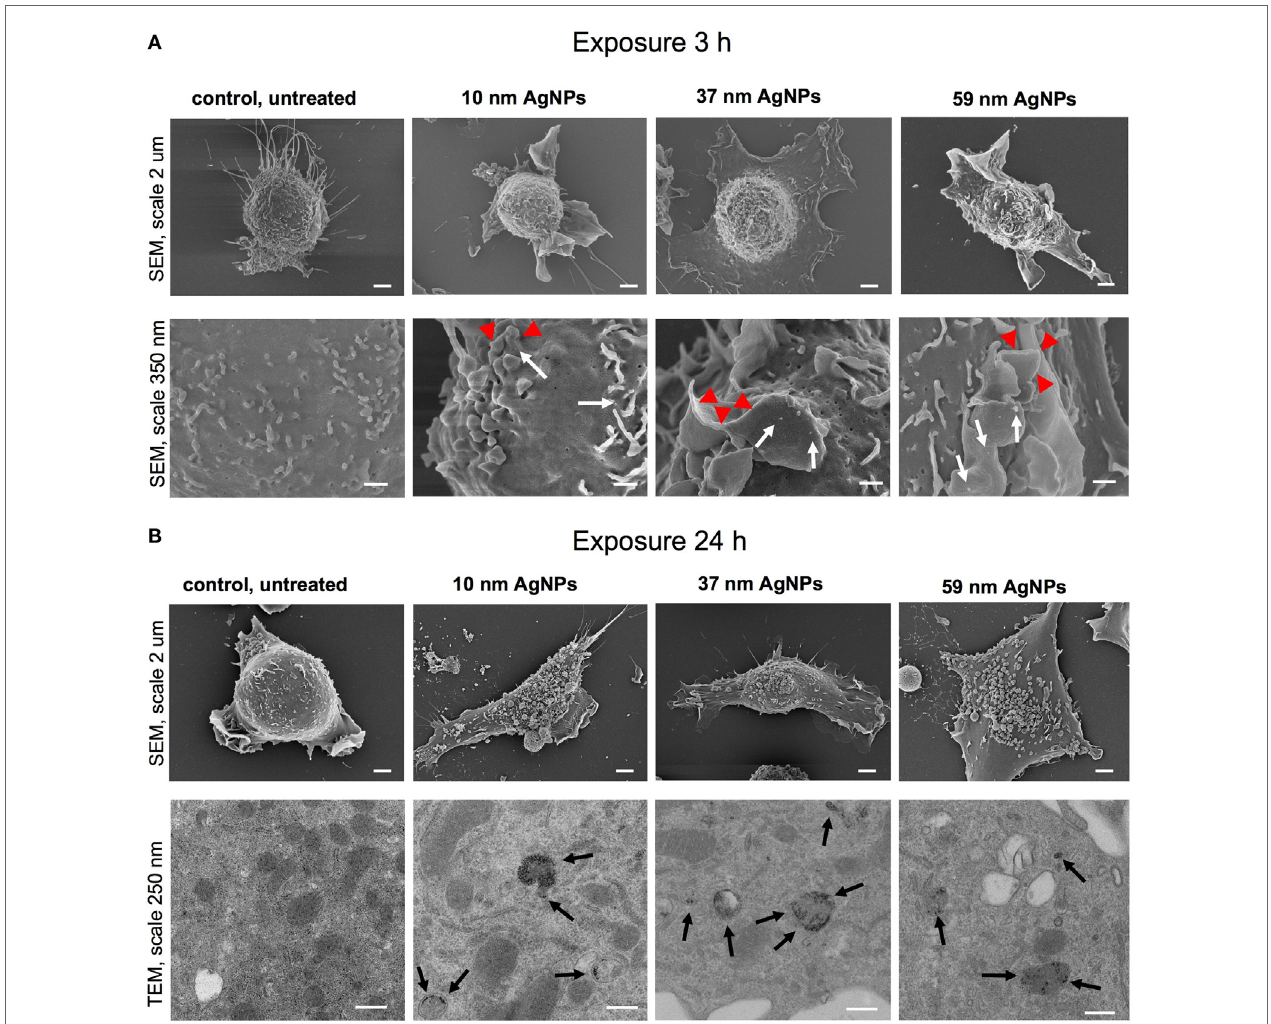
FigUre 3 | Scanning electron microscopy (SEM) and transmission electron microscopy (TEM) images of JAWS II cell line after 3 (a) and 24 h (b) of incubation with 5 µg/ml 10, 37, and 59 nm TA-AgNPs. White arrows indicate deposition of NPs, red arrowheads indicate lamellipodia, while black arrows point to intracellular deposits of AgNPs. Bars 2 μ m, 250 nm and 350 nm are